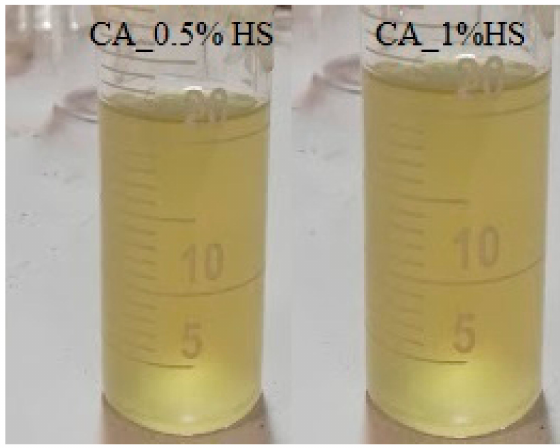
Figure 5. Birefringence flow test.